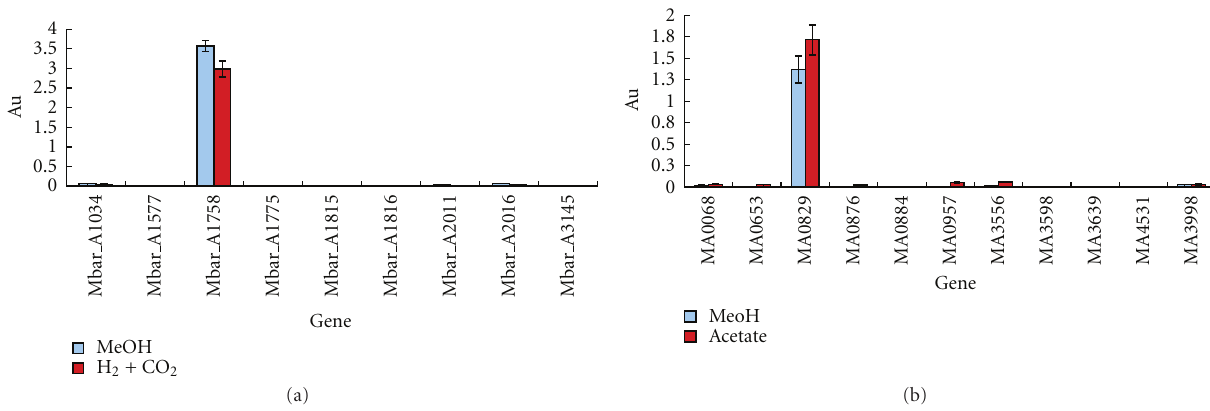
Figure 2: Expression of M. acetivorans and M. barkeri paralogous S-layer genes. (a) The Mbar A1758-related genes in M. barkeri. (b) The MA0829-related genes in M. acetivorans. Abundance values (AU) are expressed in copy number [12]. Cells were grown with methanol (MeOH), acetate, or hydrogen and carbon dioxide (H 2 + CO 2 ) as the sole carbon and energy supply as described in Section